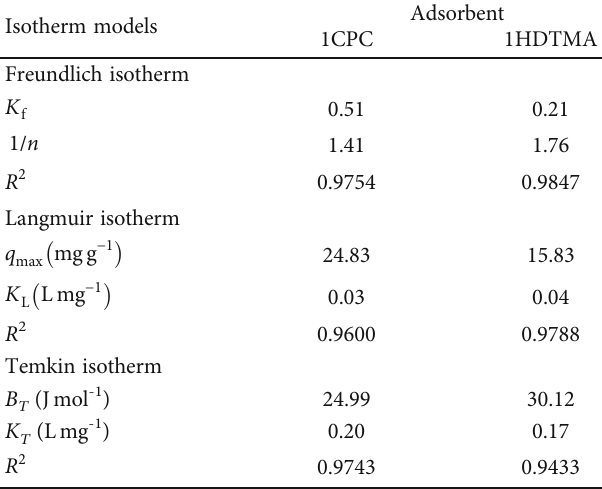
Table 6: EXAFS and Fourier transform spectral fi tting.